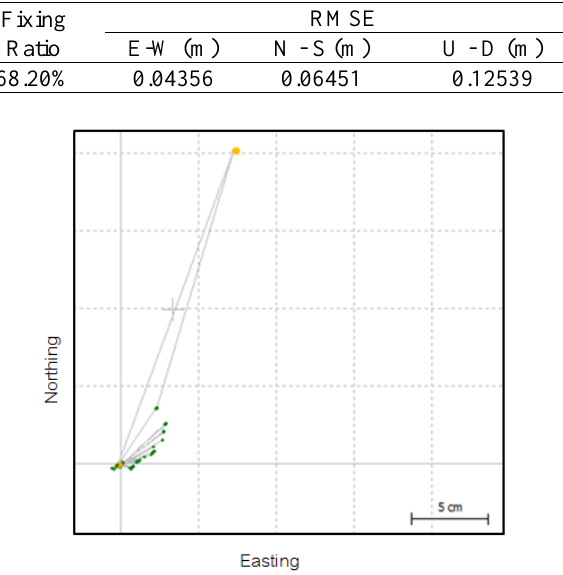
Table 1. Statistic of single frequency observation on open sky area